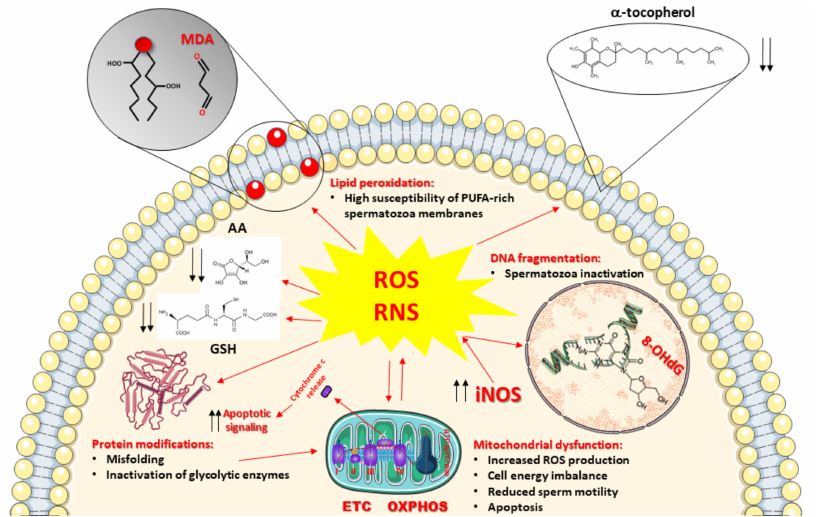
Figure 1. Schematic representation of the main sources and damaging effects of reactive oxygen species (ROS) and reactive nitrogen species (RNS) overproduction. Mitochondria are both the main intracellular source and one of the main targets of ROS. Incorrect transport of electrons through the electron transport chain (ETC) exacerbates mitochondrial ROS generation, causes a decrease in oxidative phosphorylation (OXPHOS) efficiency with a consequent decrease in ATP production and energy crisis. Increased expression of the inducible form of nitric oxide synthase (iNOS) is responsible for increased nitric oxide production. Its decomposition and reaction with ROS generate further